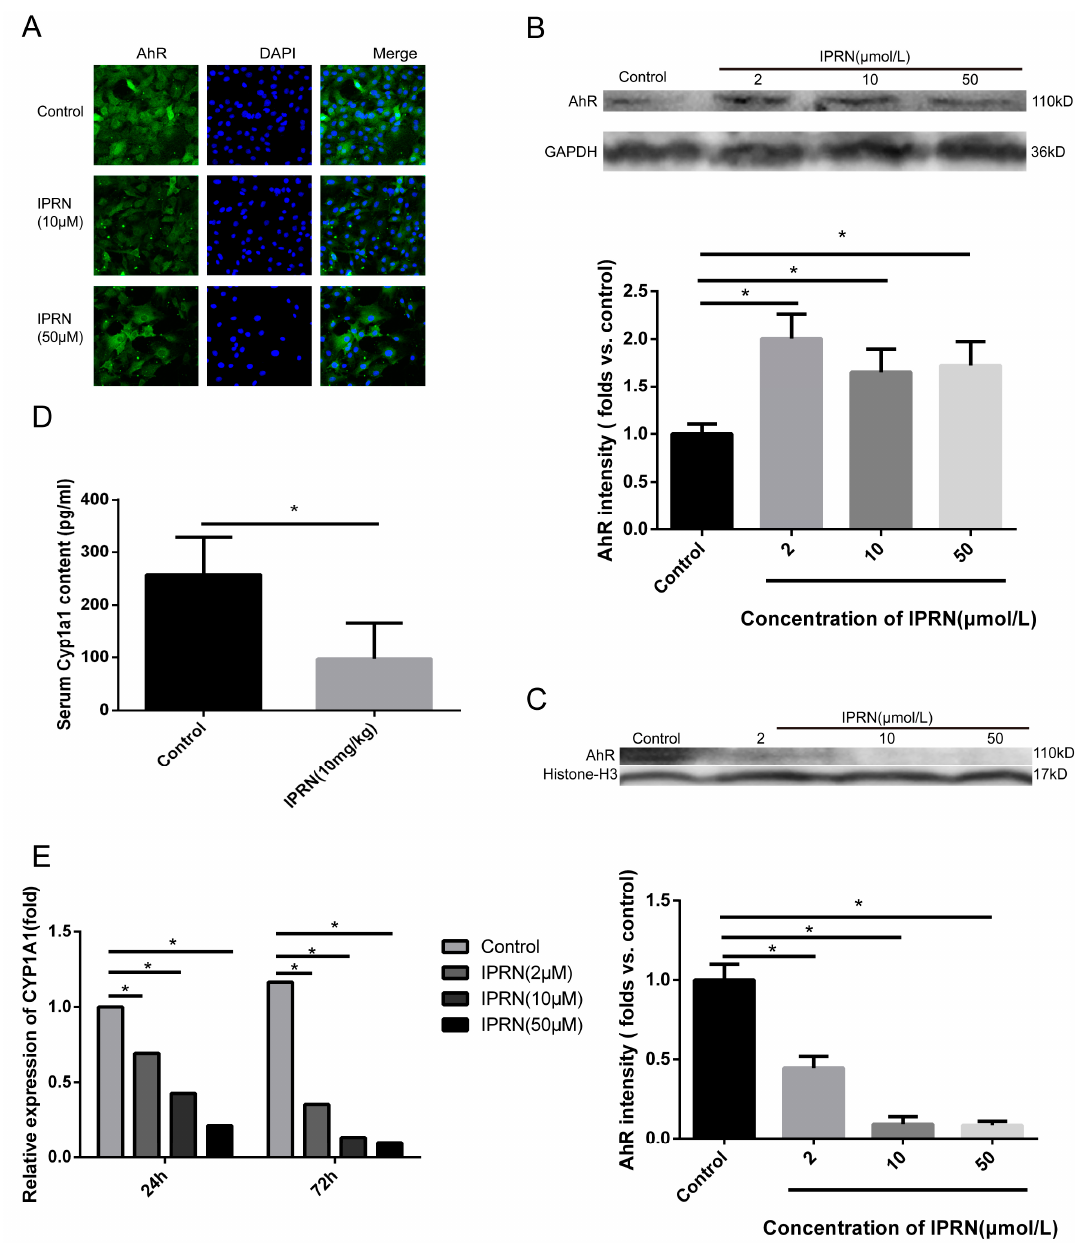
Figure 3. IPRN acted as an AhR antagonist in MC3T3-E1 cells. Immunofluorescence staining ( A ) for AhR was performed after treatment with IPRN for 24 h. The protein levels of AhR in the cytoplasm ( B ) and nucleus ( C ) were assessed by Western blotting. CYP1A1 mRNA expression ( D ) was determined by RT-qPCR ( n = 3). ( E ) CYP1A1 levels were also measured in vivo in the serum of mice after IPRN (10 mg/kg) treatment ( n = 6). Data are presented as the mean ± SD. * p < 0.05 vs. control.